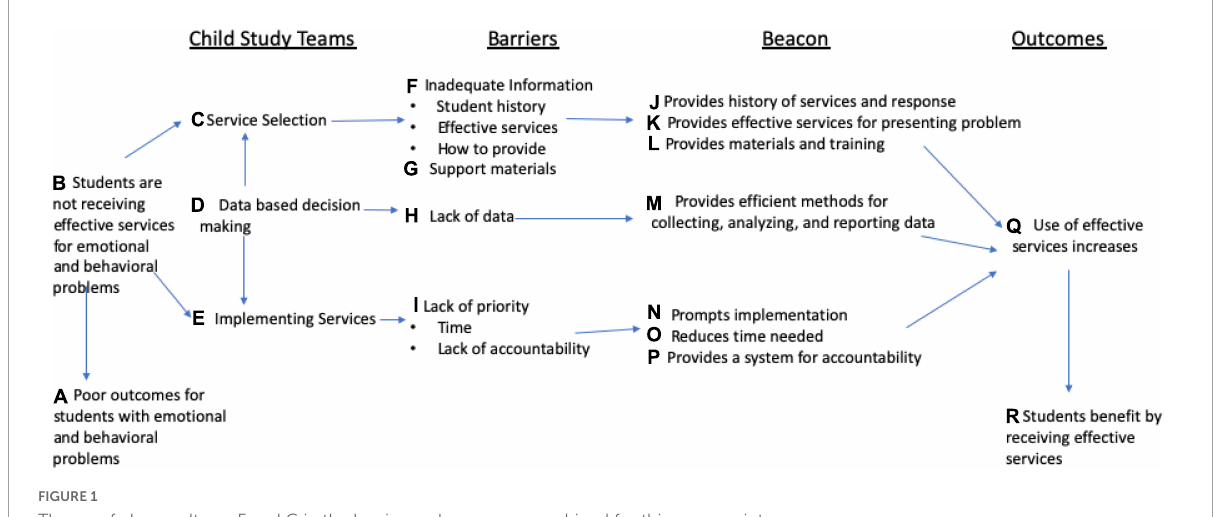
FIGURE1 Theory of change. Items F and G in the barriers column were combined for this